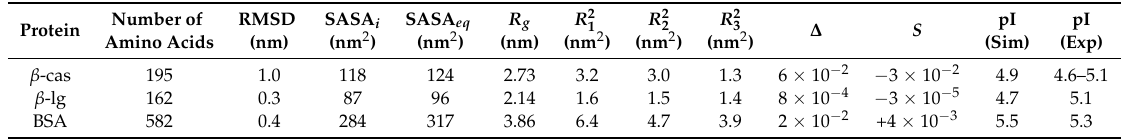
Table 1. Summary of protein data and results obtained from MD simulations of proteins in implicit solvent at 298 K (see the text for details). The RMSD corresponds to the value of the final equilibrium state compared with the initial states. The SASA is given both for the initial (SASA i ) and equilibrium (SASA eq ) states. The values for the asphericity parameter ∆ , shape parameter S , radius of gyration R g and components of the radius of gyration ( R 1 , R 2 , R 3 ) correspond to averages computed in the equilibrium state. These parameters are calculated using Equations (7)–(11). The simulation pI corresponds to the PropKa calculation, and the experimental pI corresponds to the value provided by the suppliers. SASA, solvent-accessible surface